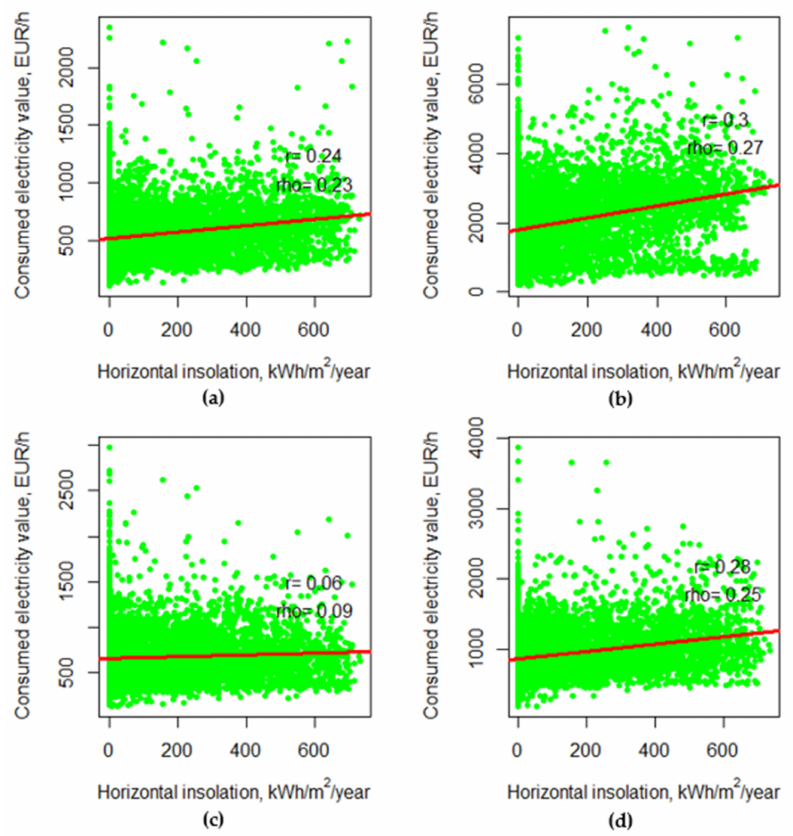
Figure 17. Correlation between the hourly values of horizontal insolation and the value of the volume of electricity consumed for the analyzed case of the research objects: ( a ) M1, ( b ) M2, ( c ) M3 and ( d ) M4. Source: own study in the RStudio environment. Table 5. Values of the correlation coefficients between the hourly values of the volumes of electricity consumed and the horizontal insolation per year (8760 h) in 4 analyzed cases of mines.